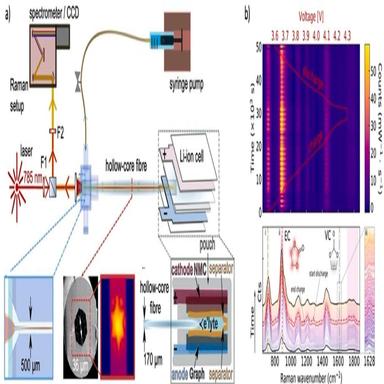
.3. Scheme for using infrared fiber to measure the IR spectra of battery electrolyte operando (a). Absorption spectra as a function of state of charge (b). Changes to the relative spectra during charging and discharging showing the formation of degradation species and changes to the coordination environments in the electrolyte (c).